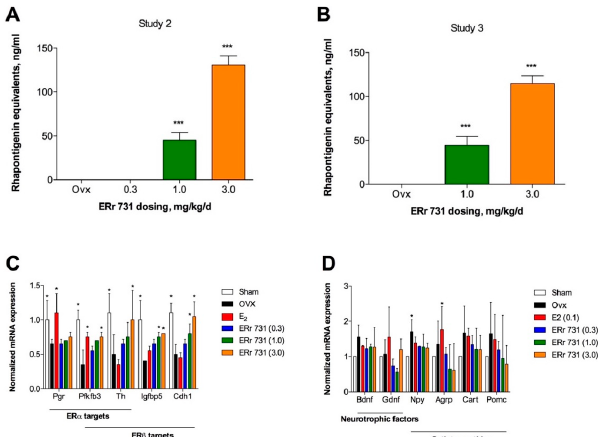
Figure 6. Plasma concentration of ERr 731 metabolite and the pharmacogenomic profiles for ER α / β target genes and bioactive peptides in the hypothalamus of ERr 731-treated rats. ( A ) Rhaponticin metabolite was detected in the plasma of rats treated orally with 0.3–3 mg/kg/day ERr 731 for 14 days in study 2 and ( B ) 7 days in study 3. ( C ) E 2 treatment significantly upregulated ER α but not ER β target genes in the hypothalamus of OVX rats, and the opposite effect was ob- served for ERr 731. ( D ) Neither E 2 nor ERr 731 modulated the expression of neurotrophic factors; however, an agouti-related peptide Agrp was significantly elevated following the OVX surgery and ERr 731 treatment abolished this response. Individual hypothalamic tissue samples ( n = 6) were analyzed by fluorescent quenching ( A , B ) or qPCR ( C , D ), and the data were expressed as the mean ± SEM, * p < 0.05 and *** p < 0.001 vs. OVX control. 2.6. ERr 731 Shows a Selective ER β Agonist Activity In Vitro ERr 731 had little effect on ER α , causing a less than 3-fold increase over the maximum reported activity (Figure 7A), but strongly activated ER β to a 36-fold increase over the maximum reported activity (Figure 7B). Similar to genistein and (S)-equol, ERr 731 and its major bioactive aglycone, rhapontigenin, acted as full ER β agonists (Figure 7C,D). Overall, ERr 731 showed a 13.5-fold difference in ER β /ER α specificity when compared to E 2 at a maximum receptor activation value. The specificities for the other known estro- genic compounds were much smaller, in the range of 0.31 for E 2 , 0.37 for equol, 0.3 for genistein, and 3.2 for quercetin.